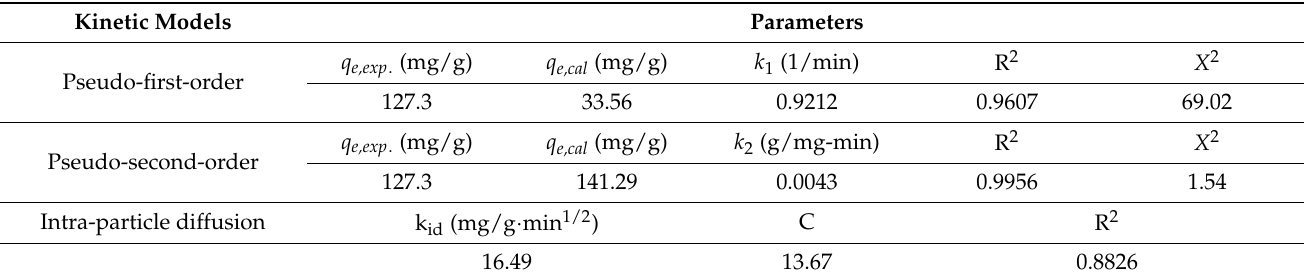
Table 1. Kinetic modeling parameters for BG adsorption on